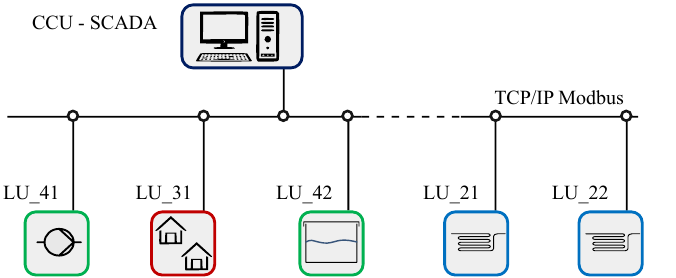
Figure 11. Communication network architecture of the SWIL that connects the CCU and LUs via TCP/IP